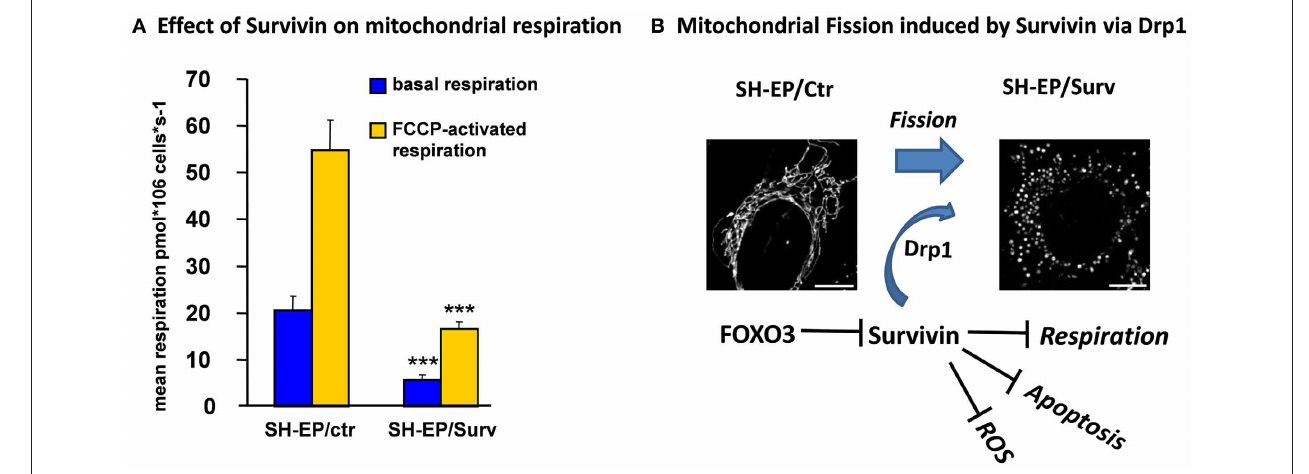
FIGURE 3 | The FOXO3-target Survivin reduces mitochondrial respiration and induces mitochondrial fission in neuronal tumor cells via Drp1 recruitment to mitochondria. Ectopic expression of the anti-apoptotic protein Survivin in neuroblastoma cells reduces basal and FCCP-activated mitochondrial respiration to about one third of control cells. Oxygen consumption of the cells and mitochondrial function were analyzed by high-resolution respirometry (Kuznetsov et al., 2008), using a two-channel Oroboros Oxygraph respirometer. This reduced respiratory activity results